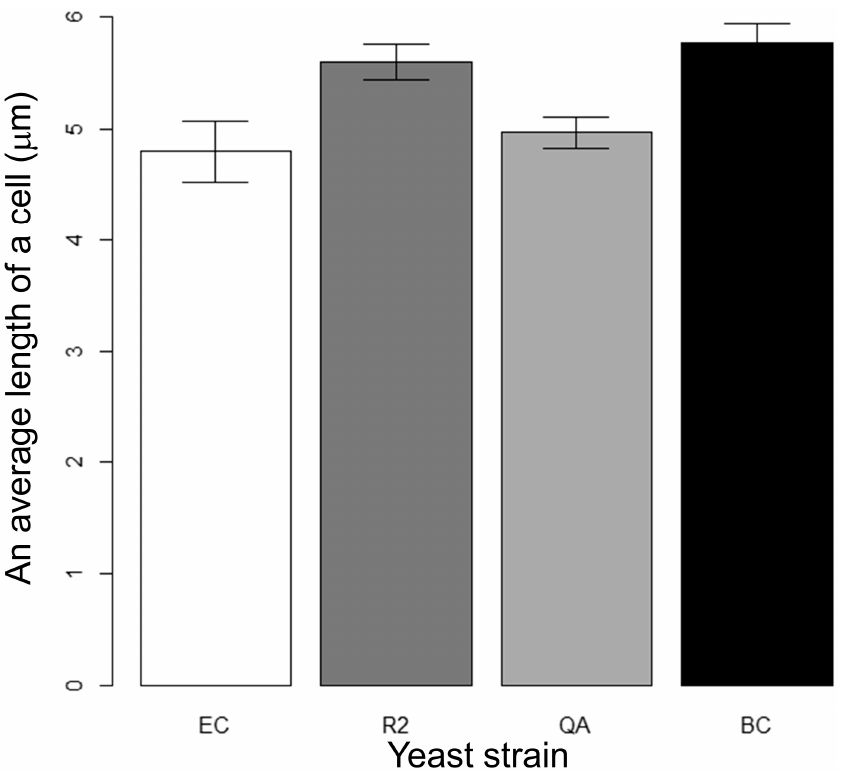
Figure 4. Cell length results using the proposed method of the present study (using a digital microscope). More than 30 cells are measured for each yeast strain. Results are presented as means and standard deviations with error bars. Significant differences were observed between EC with R2, EC with BC, R2 with QA and QA with BC ( p -values were 9.7 × 107, 0.04, 5.9 × 1015 and 0.01, respectively, these values are smaller than 0.05). No significant differences were observed between EC with QA and R2 with BC ( p -values were 0.28, and 0.55, respectively; these values are greater than 0.05). Table 1. p -value for statistical differences evaluation. p -Values (Area) for t -Test Pairs for Strains Proposed Measurements for Area Proposed Measurements for